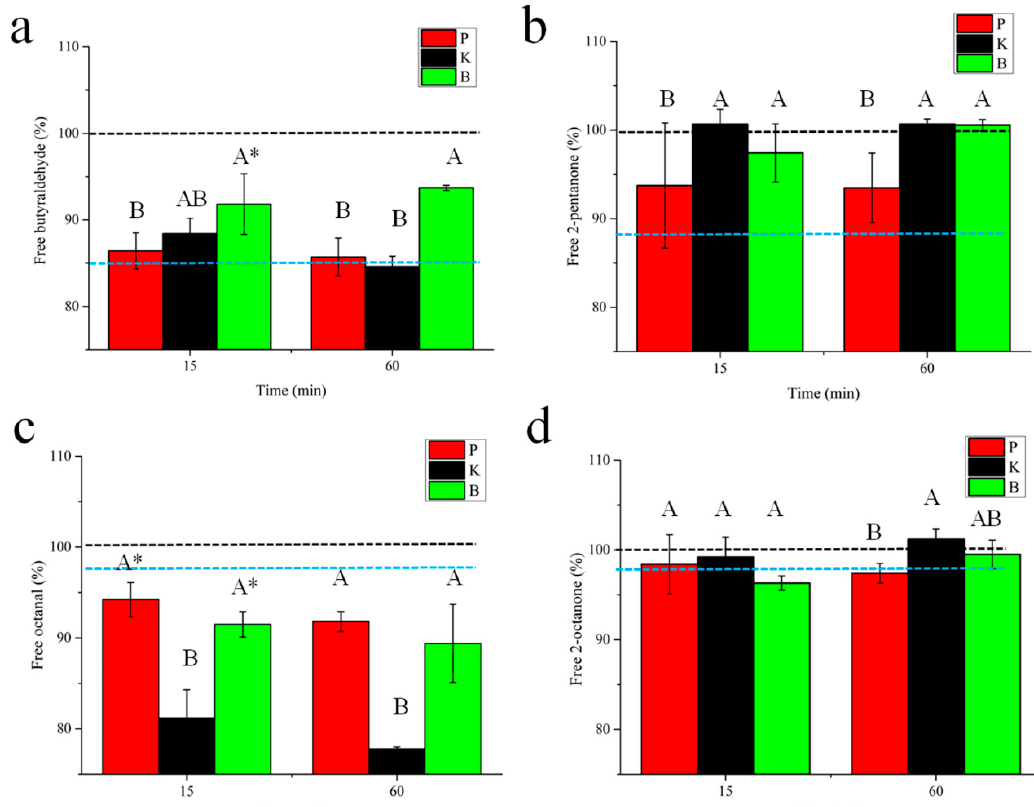
Figure 5. Changes in absorption of MP solution to butyraldehyde ( a ), 2-pentanone ( b ), octanal ( c ), and 2-octanone ( d ) affected by treatment with papain (P), proteinase K (K), or bromelain (B) for 0 (blue dotted line), 15, and 60 min. Uppercase letters A,B indicate significance level differences among different enzymes. Symbol * indicates significant differences between samples treated with the same enzyme for 15 and 60 min. Each measurement was repeated in triplicate.